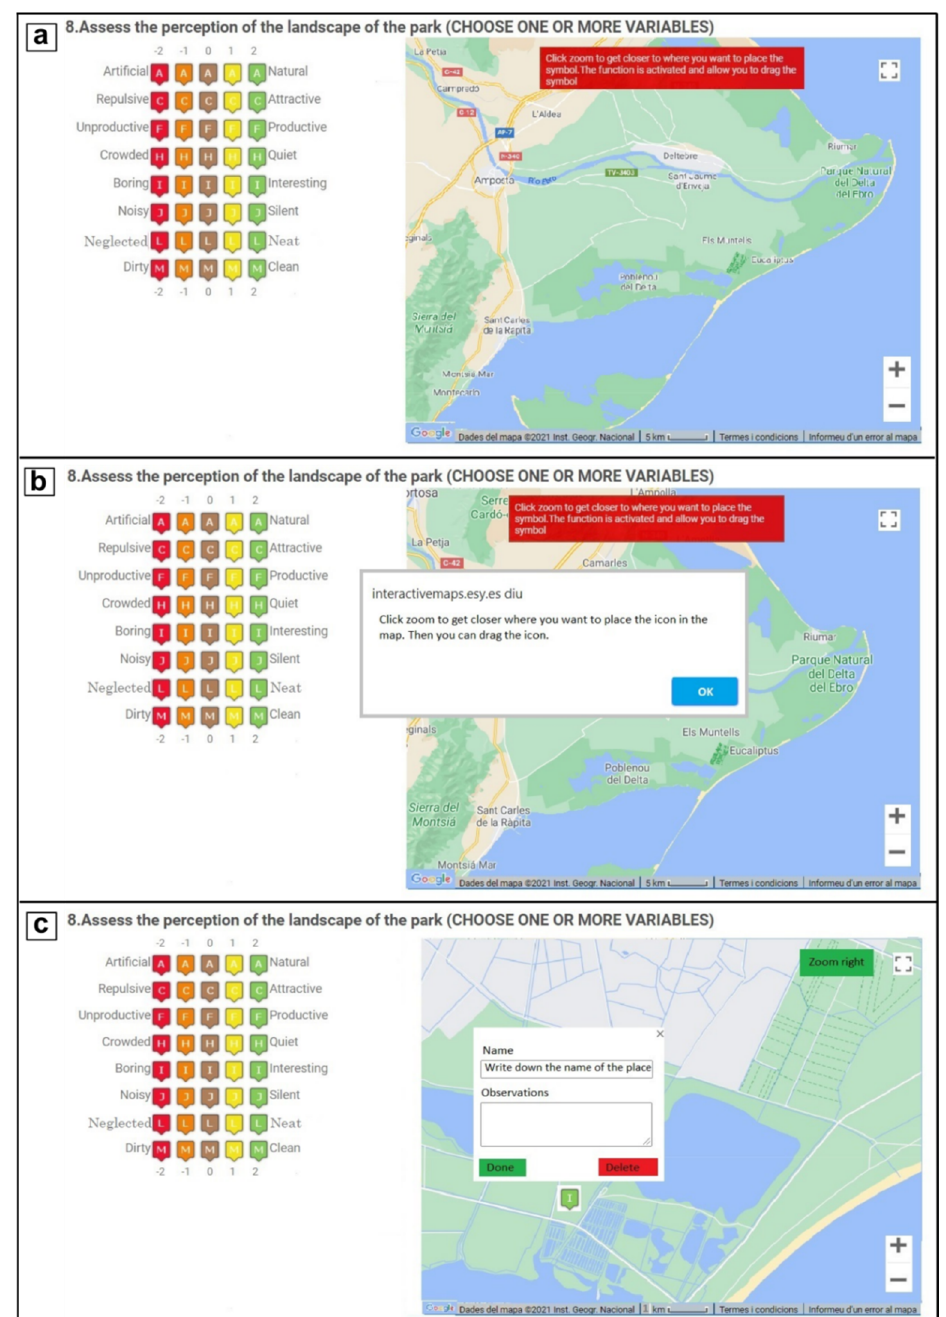
Figure 2. Screenshots of questionnaire: ( a ) display at 5 km scale; ( b ) a warning appears when trying to give input at this scale; ( c ) display at 1 km scale. A version of the questionnaire can be found at http://interactivemaps.esy.es/web/index_de_en.html (13 June